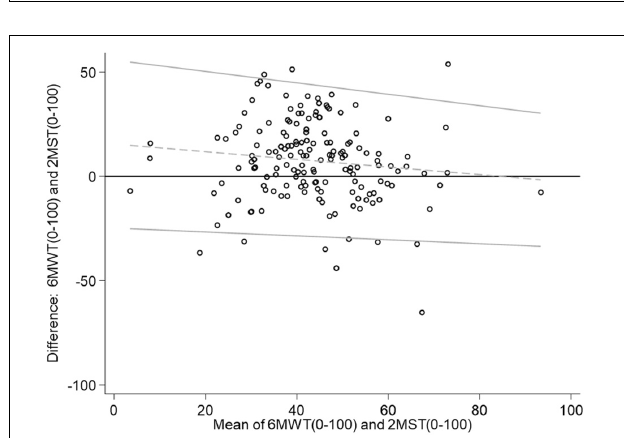
FIGURE 2 | Bland–Altman plot.